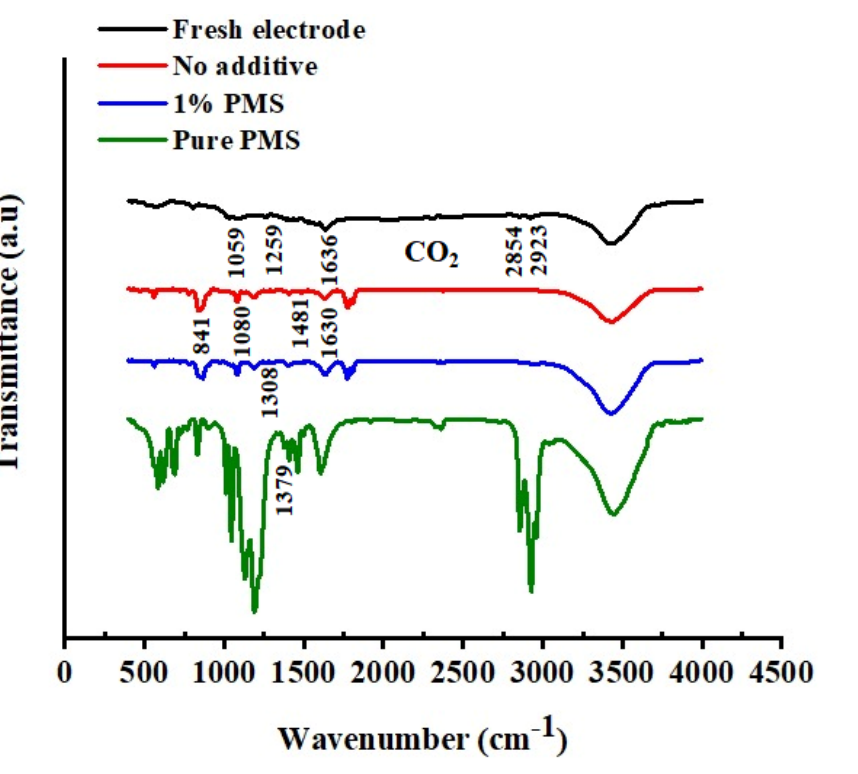
Figure 6. The FT-IR spectra of graphite electrodes before cycling (fresh electrode), after cycling in the electrolyte without additive, after cycling in the electrolyte containing PMS, and PMS powder (pure PMS).